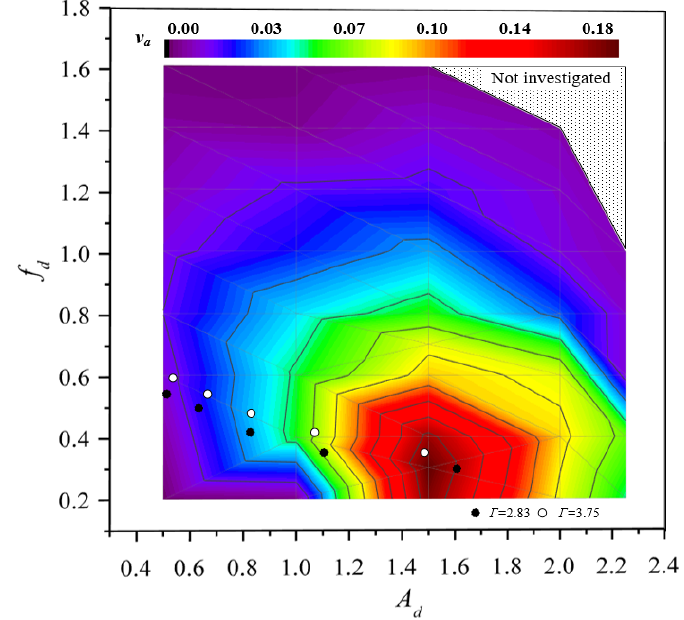
Figure 10. v a as a function of f d and A d for the intruder of d Sau = 6 mm, a / b = 3.0. ○ and ● show the vibration conditions used in [31].